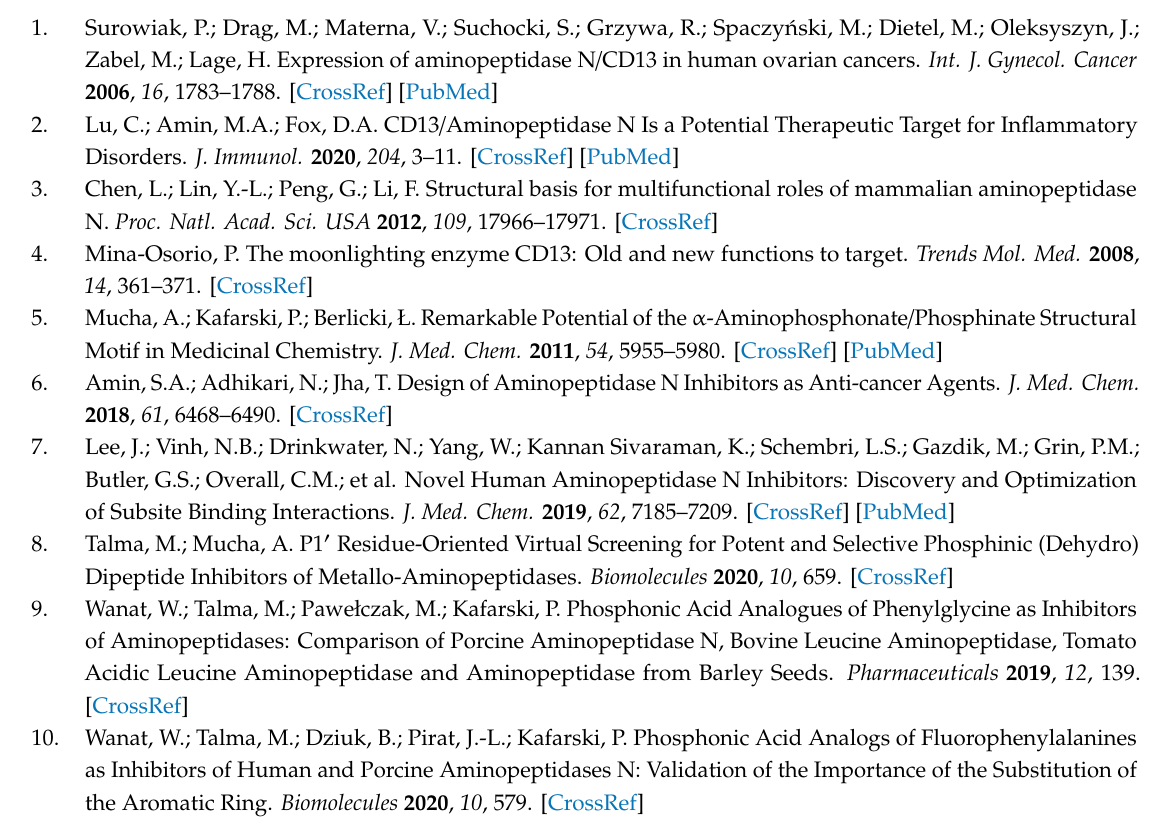
and experimental details of the X-Ray data collection for structure 13a , 13c and 14c. Table S9-2: Selected geometric parameters for crystal structure 13a (Å, º). Table S9-3: Selected hydrogen-bond parameters for structure 13a . Table S9-4: Selected geometric parameters for crystal structure 13c (Å, º). Table S9-5: Selected geometric parameters for crystal structure 14c (Å, º). Table S9-6: Selected hydrogen-bond parameters for structure 14c . Section S10: Characterization of the Final Compounds 15a–15h and 17a–17e by 1 H, 13 C, 19 F, 31 P NMR. Figure S10-1: 1 H ( A ), 31 P ( B ) NMR spectra for compound 15a . Figure S10-2: 1 H ( A ), 13 C ( B ), 19 F ( C ), 31 P ( D ) NMR spectra for compound 15b . Figure S10-3: 1 H ( A ), 13 C ( B ), 19 F ( C ), 31 P ( D ) NMR spectra for compound 15c . Figure S10-4: 1 H ( A ), 13 C ( B ), 19 F ( C ), 31 P ( D ) NMR spectra for compound 15d . Figure S10-5: 1 H ( A ), 13 C ( B ), 19 F ( C ), 31 P ( D ) NMR spectra for compound 15e . Figure S10-6: 1 H ( A ), 13 C ( B ), 19 F ( C ), 31 P ( D ) NMR spectra for compound 15f . Figure S10-7: 1 H ( A ), 13 C ( B ), 19 F ( C ), 31 P ( D ) NMR spectra for compound 15g . Figure S10-8: 1 H ( A ), 13 C ( B ), 19 F ( C ), 31 P ( D ) NMR spectra for compound 15h . Figure S10-9: 1 H ( A ), 13 C ( B ), 19 F ( C ), 31 P ( D ) NMR spectra for compound 17a . Figure S10-10: 1 H ( A ), 19 F ( B ), 31 P ( C ) NMR spectra for compound 17b . Figure S10-11: 1 H ( A ), 13 C ( B ), 19 F ( C ), 31 P ( D ) NMR spectra for compound 17c . Figure S10-12: 1 H ( A ), 13 C ( B ), 19 F ( C ), 31 P ( D ) NMR spectra and HPLC ( E ) for compound 17d . Figure S10-13: 1 H ( A ), 13 C ( B ), 19 F ( C ), 31 P ( D ) NMR spectra for compound 17e